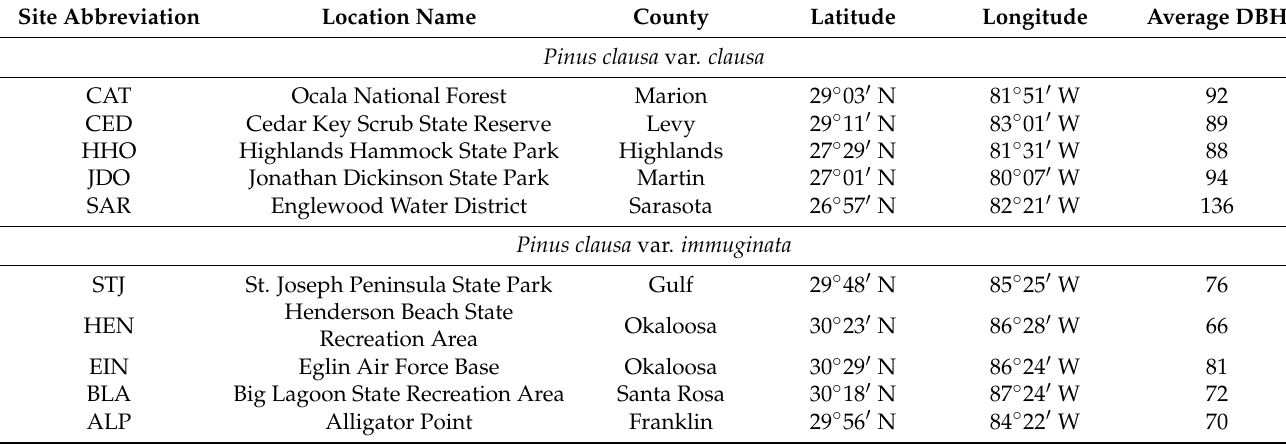
Table 1. Locations and average diameters at breast height (DBHs; cm) for the sampling of Pinus clausa . Site